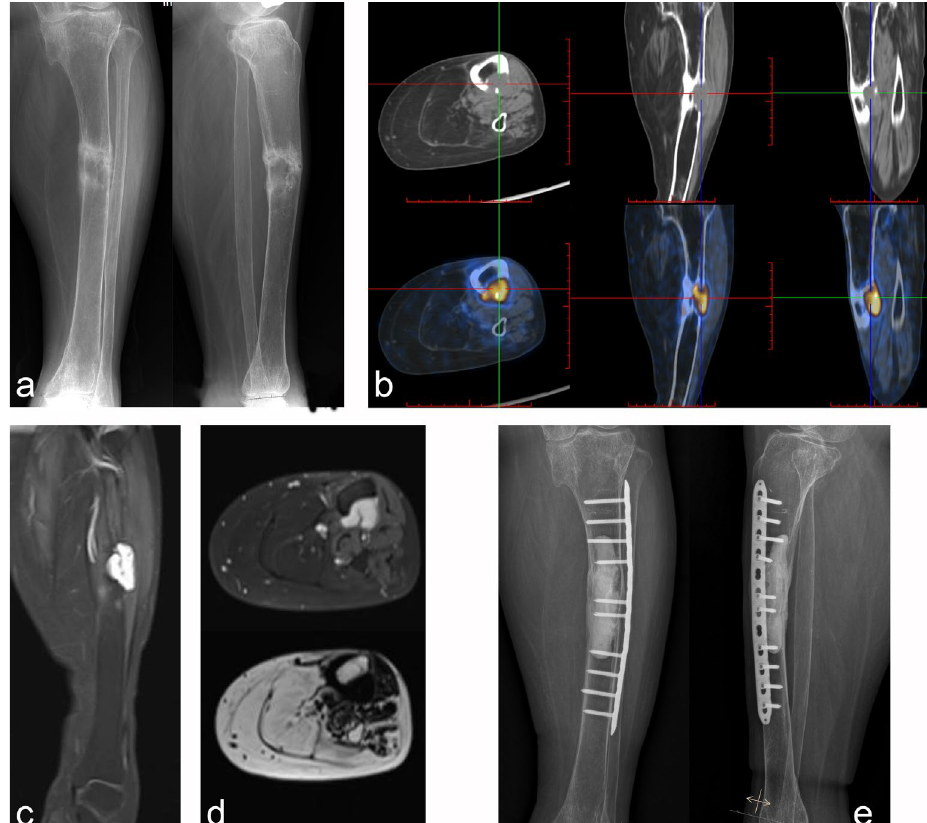
Figure 4. Case 5: PMT of the middle tibia with pathologic fracture underwent microwave ablation- assisted extended curettage. ( a ) Anteroposterior and lateral X-rays showed osteolytic lesions in the middle tibia with pathological fractures and obvious hardening of the fracture ends. ( b ) Tc99m- octreotide PET/CT scan showed an abnormal concentration of the lesion. ( c , d ) MRI showed low intensity on T1WI and high intensity on T2WI, with obvious enhancement after lipid suppression enhancement. ( e ) Microwave ablation-assisted extended curettage was performed, followed by cement filling and assisted by an internal fixation device. Table 2. Comparative statistical analysis of various factors.